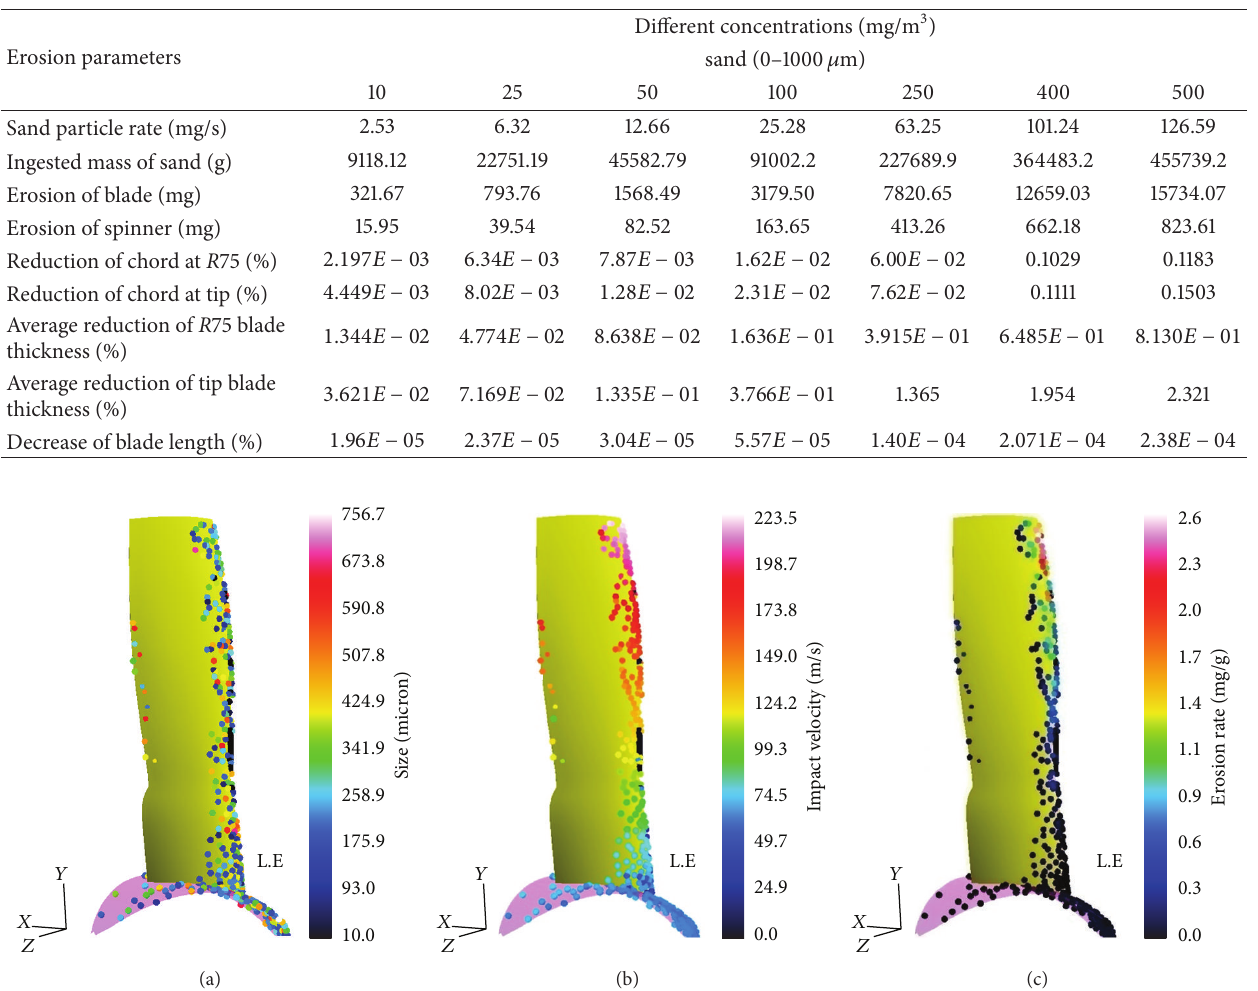
Figure 10: Sample of local impacts on suction side: (a) particles sizes ( 𝜇 m), (b) impact velocities (m/s), and (c) erosion rates (mg/g).